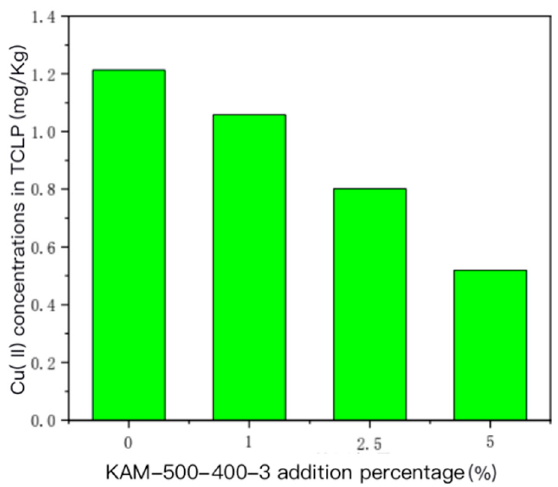
Figure 8. Cu(II) concentrations in TCLP leachates of Cu(II)–Cd(II) mixed contaminated sediment under different addition percentages of KAM500-400-3(%).